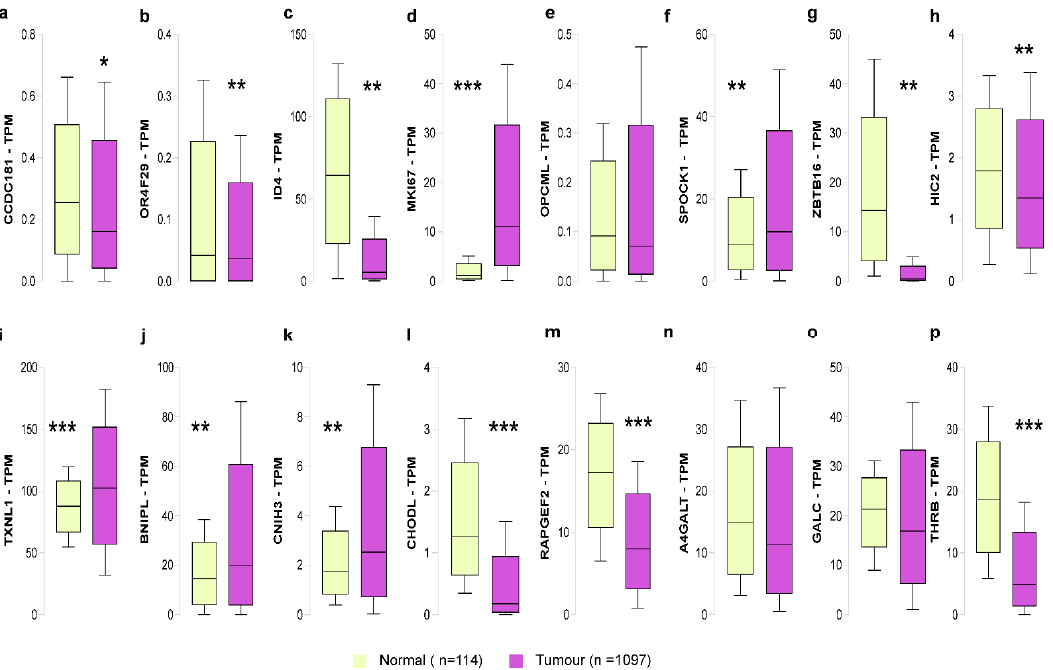
Figure 4. Gene expression analysis of 5-mC and 5-hmC specific loci in breast tumour and normal samples. ( a – f ) Gene expression analysis of hyper- and hypo-mC candidates. ( g – p ); Gene expression analysis of hyper- and hypo-hmC candidates using UALCAN webtool (*** p < 0.0001; ** p < 0.001, and * p < 0.05).